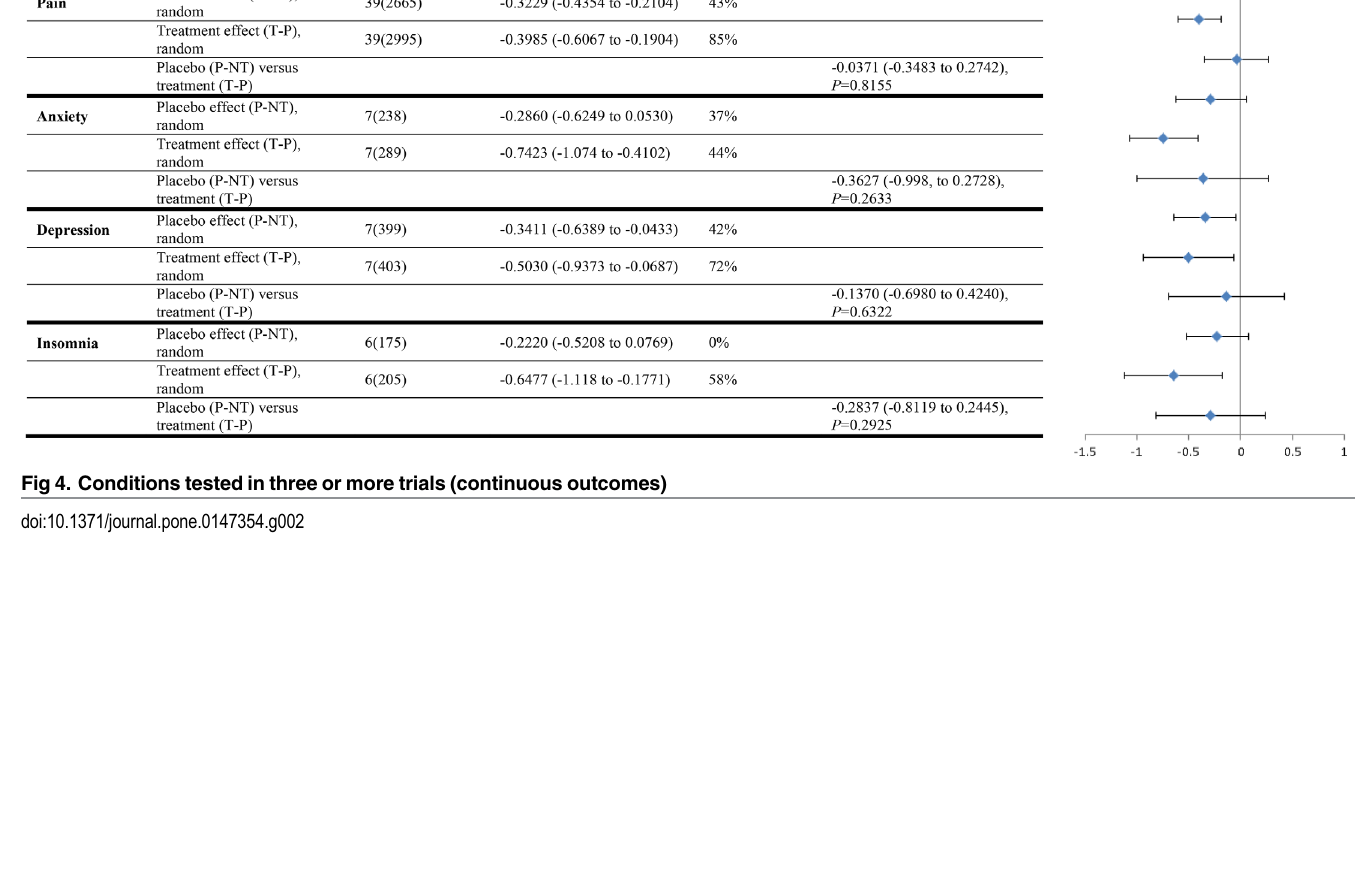
PLOS ONE | DOI:10.1371/journal.pone.0147354 January 15,